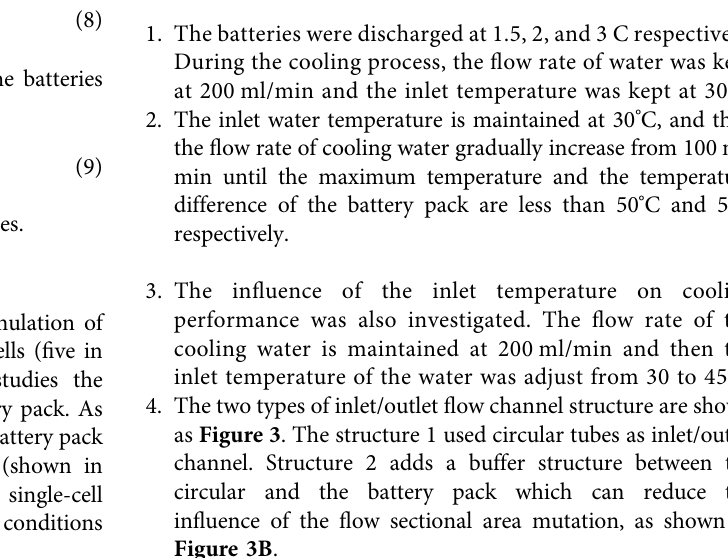
Frontiers in Energy Research |